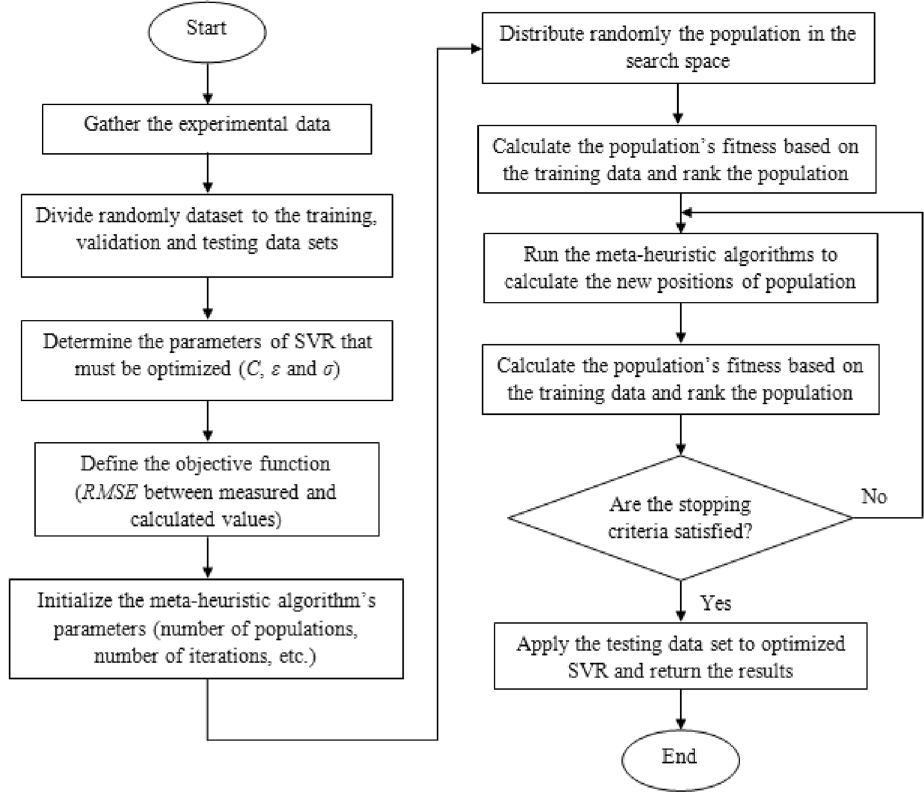
Figure 1. SVR- HGSO and SVR- EO flowchart.